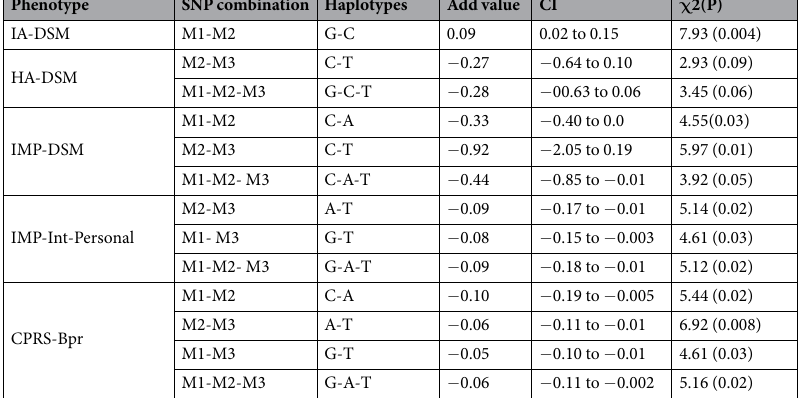
Variant Allelic combination Game1